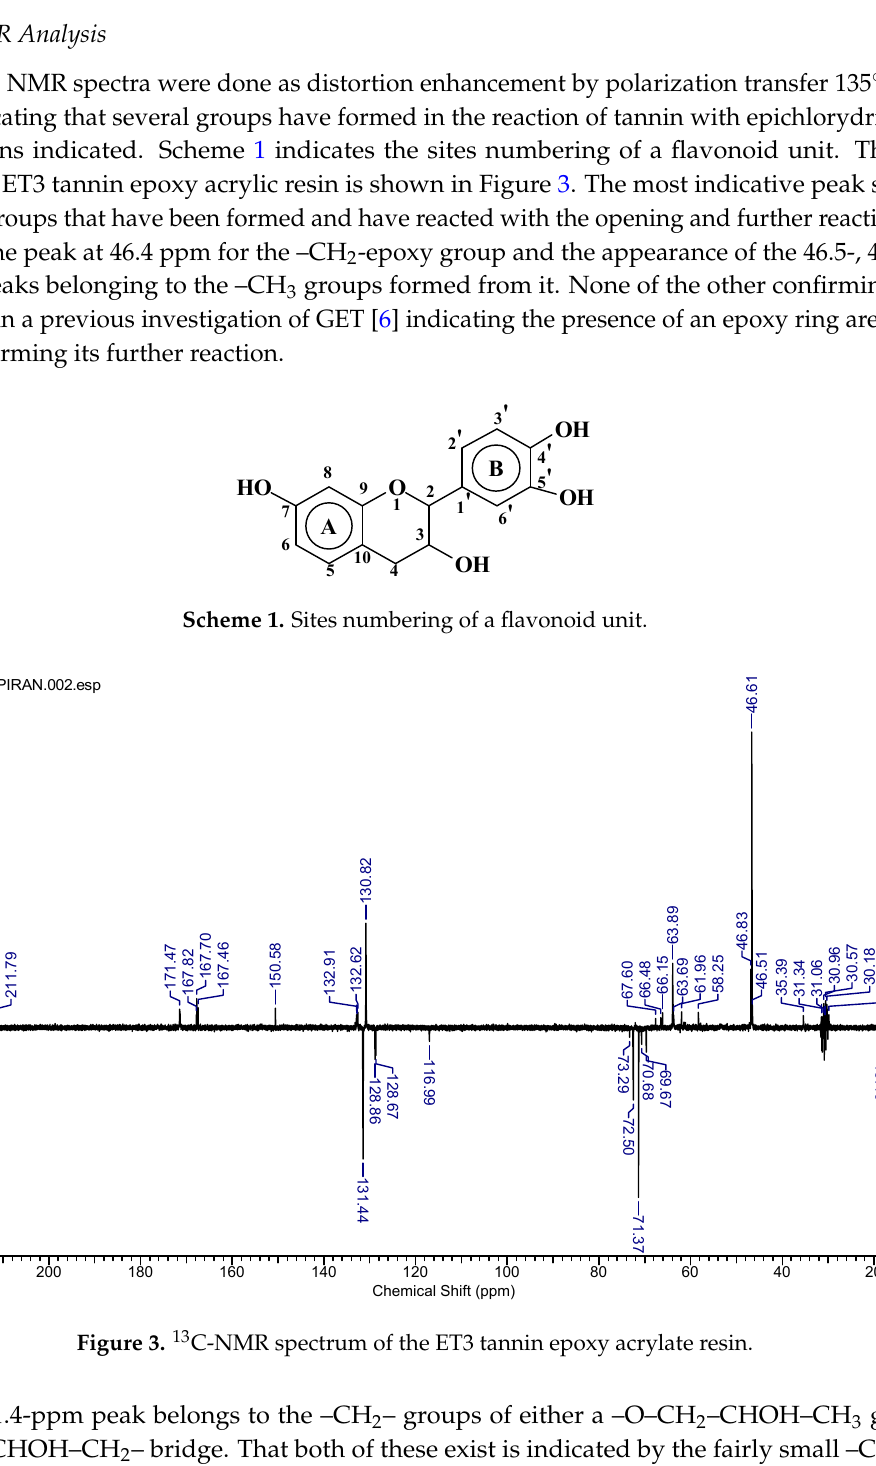
Figure 3. 13 C-NMR spectrum of the ET3 tannin epoxy acrylate resin.